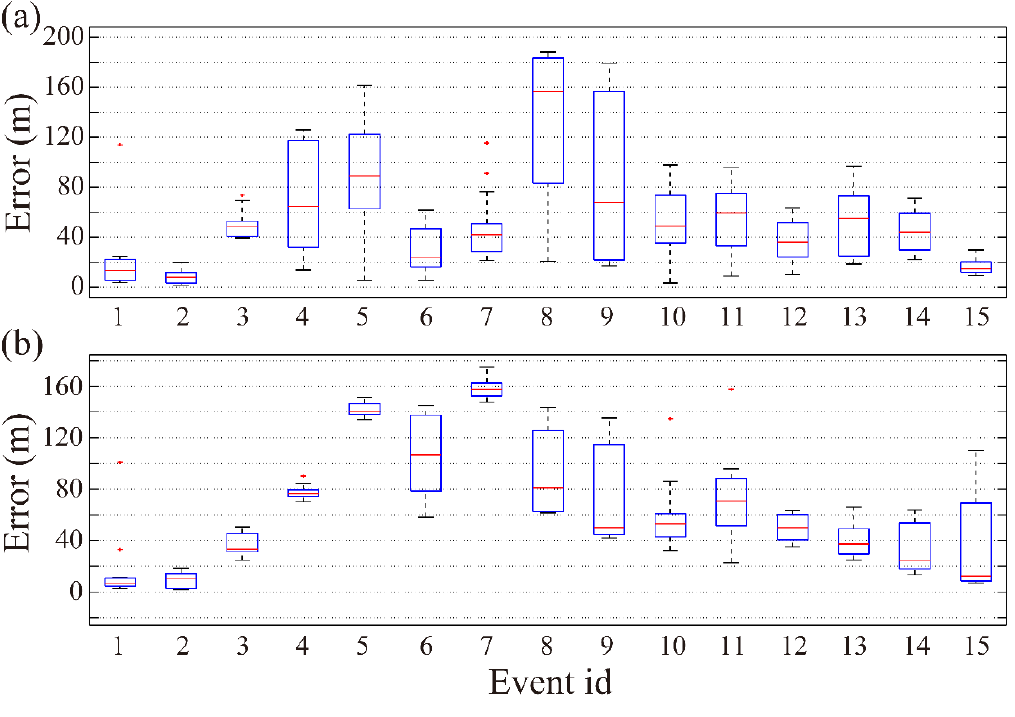
Figure 7. Location error boxplots of the 15 test events using the GBRTM location method under different homogeneous velocity models (from 3400 to 4700 m/s). ( a ) Boxplots of location errors under the synthetic data from 2D velocity model with the low-velocity anomaly; ( b ) Boxplots of location errors under the synthetic data from 2D velocity model with the high-velocity anomaly.